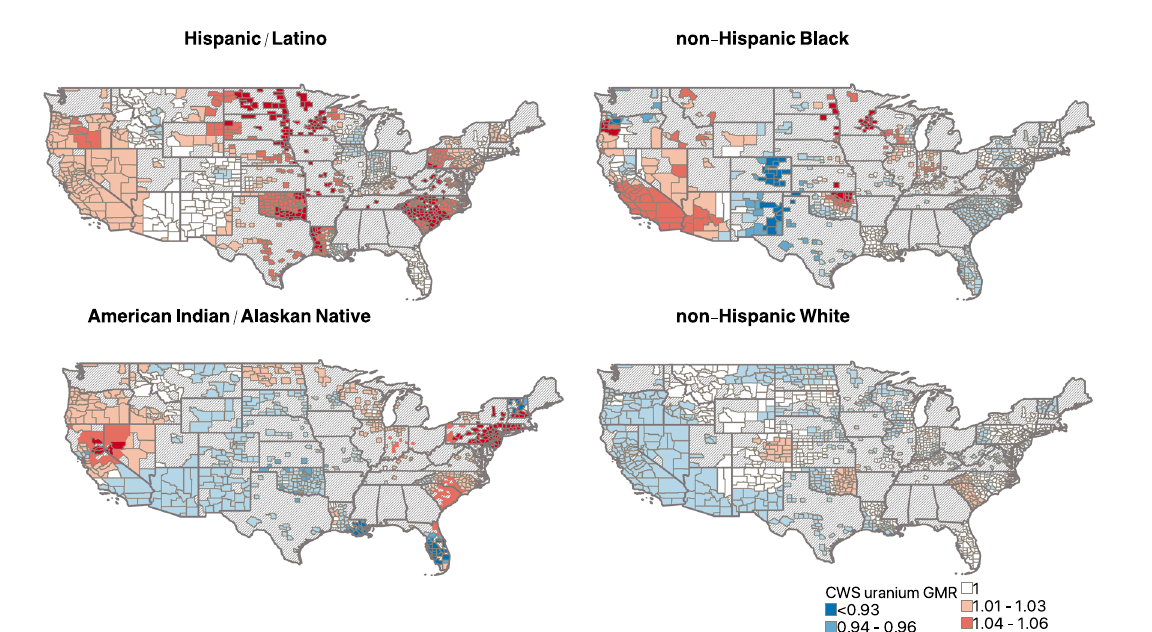
Fig. 2|Directionandmagnitudeofthegeometricmeanratio(GMR)ofcounty- level community water system (CWS) arsenic concentrations per 10 percent higher county proportion of non-Hispanic Black, American Indian/Alaskan Native, Hispanic/Latino, and non-Hispanic White residents from geo- graphically weighted regression models. Models were adjusted for population density, the percent of public drinking water supplied from groundwater sources, median household income, and the percent of residents with a high school diploma. Counties with a positive effect estimate (GMR>1) are shown in red scale